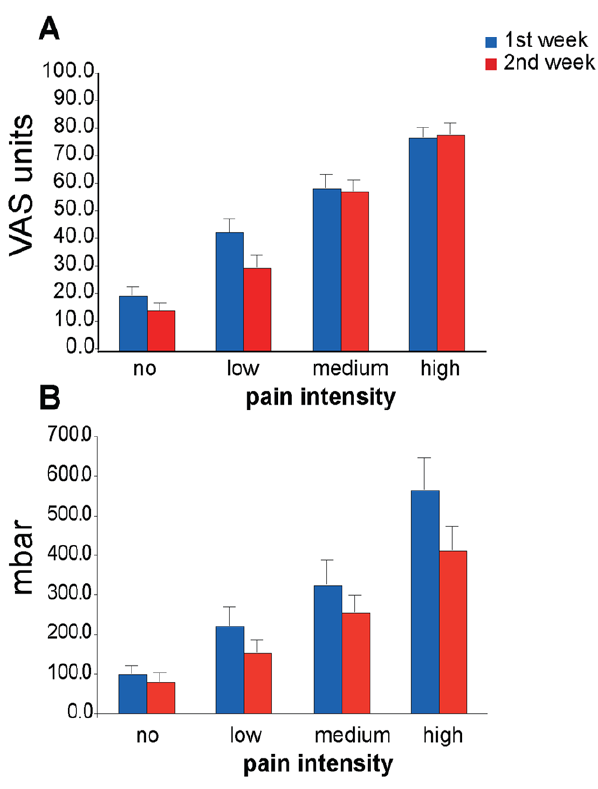
Figure 2. Medium pain ratings of four distinct pain levels (A) VAS (B) PM. All comparisons between the pain intensities were significant (p # 0.05) for VAS and PM. Bars depict average values and their S.E. Please note that for the VAS, ratings for medium- and high- pain levels do not change over time in contrast to PM values for the same pain levels (see